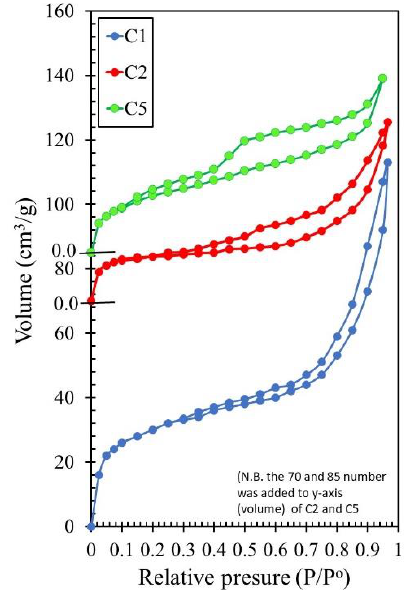
Figure 4. Nitrogen adsorption–desorption isotherms for C1, C2 and C5 clays. Table 3. Surface characteristic parameters (viz., BET surface area (S BET ), pore volume (Vp), pore radius (r), cumulative surface area (S cum ) and cumulative pore volume (V cum )) and point of zero charge (P.Z.C) calculated from potentiometric titration of clays in the study. Clay